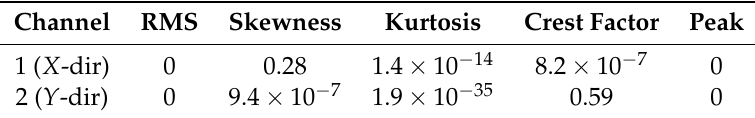
Table 2. The ANOVA p -values considering two groups: Healthy (TS1 to 9) vs Damaged (TS10 to 18). Channel RMS Skewness Kurtosis